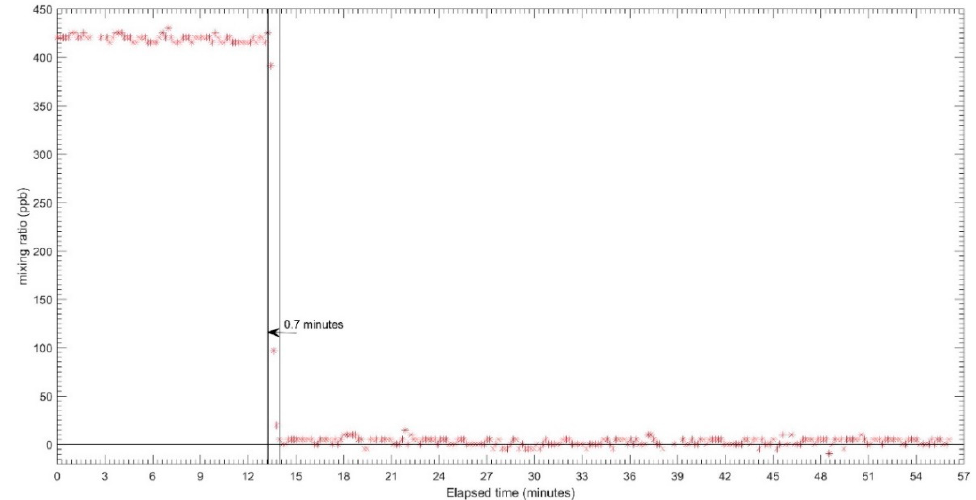
Figure 7. Response time of NO 2 -A43F sensor from target gas to zero.